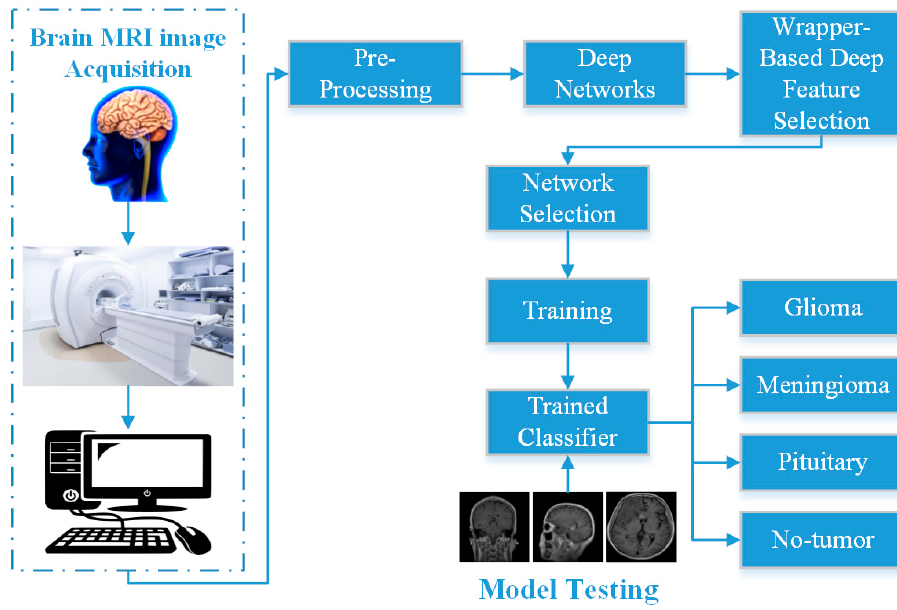
Figure 3. Block diagram of the proposed WBM-DLNets.